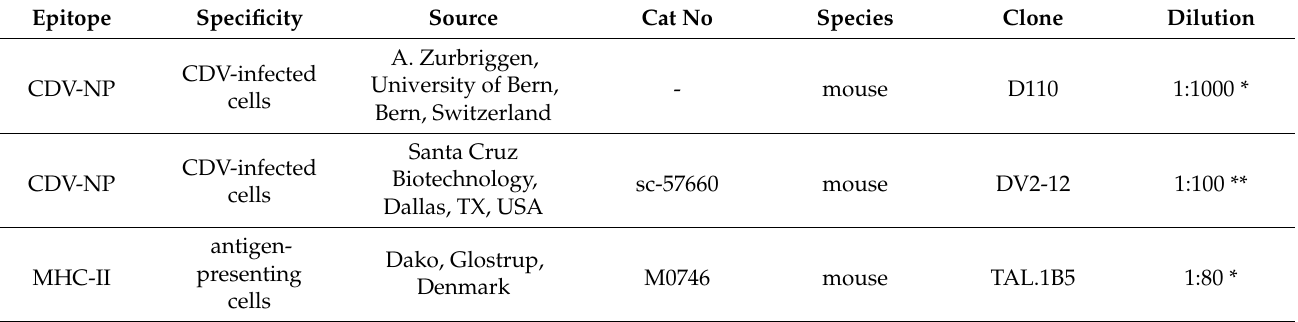
Table 2. Primary antibodies used for immunohistochemistry and